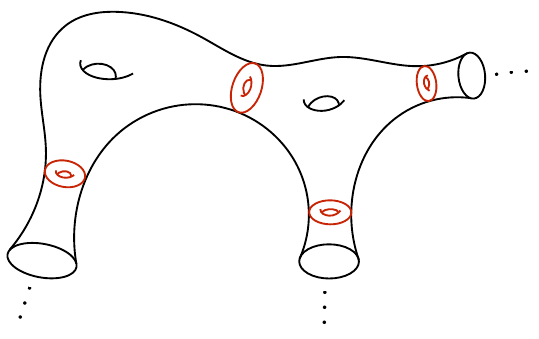
Figure 5 . Cutting 3-manifolds along T 2